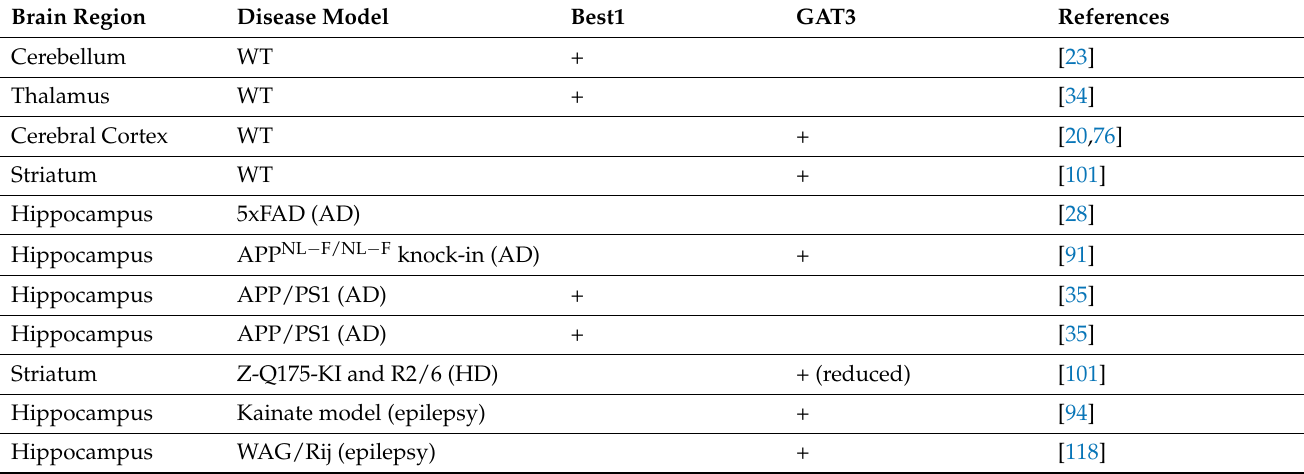
Table 1. Best1-channel- and GAT3-mediated GABA release in mouse models. Brain Region Disease Model Best1